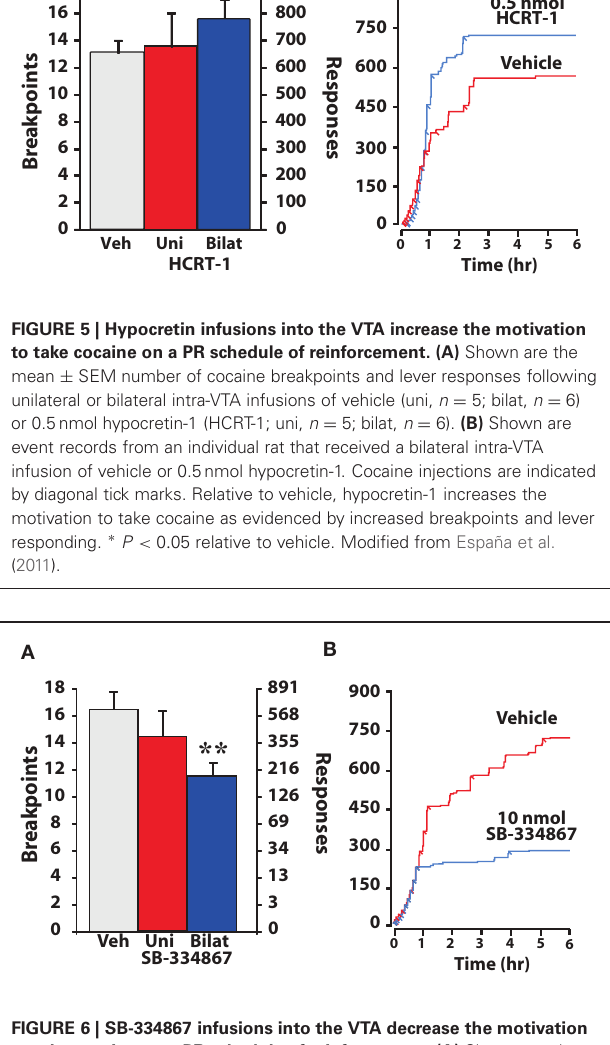
FIGURE 6 | SB-334867 infusions into the VTA decrease the motivation to take cocaine on a PR schedule of reinforcement. (A) Shown are the mean ± SEM number of cocaine breakpoints and lever responses following unilateral or bilateral intra-VTA infusions of vehicle (uni, n = 5; bilat, n = 6) or 10nmol SB-334867 (uni, n = 5; bilat, n = 6). (B) Shown are event records from an individual rat that received an i.p. injection of vehicle or 30mg/kg SB-334867. Cocaine injections taken are indicated by diagonal tick marks. Relative to vehicle, SB-334867 decreases the motivation to take cocaine as evidenced by decreased breakpoints and lever responding. ∗∗ P < 0 . 01 relative to vehicle. Modified from España et al.